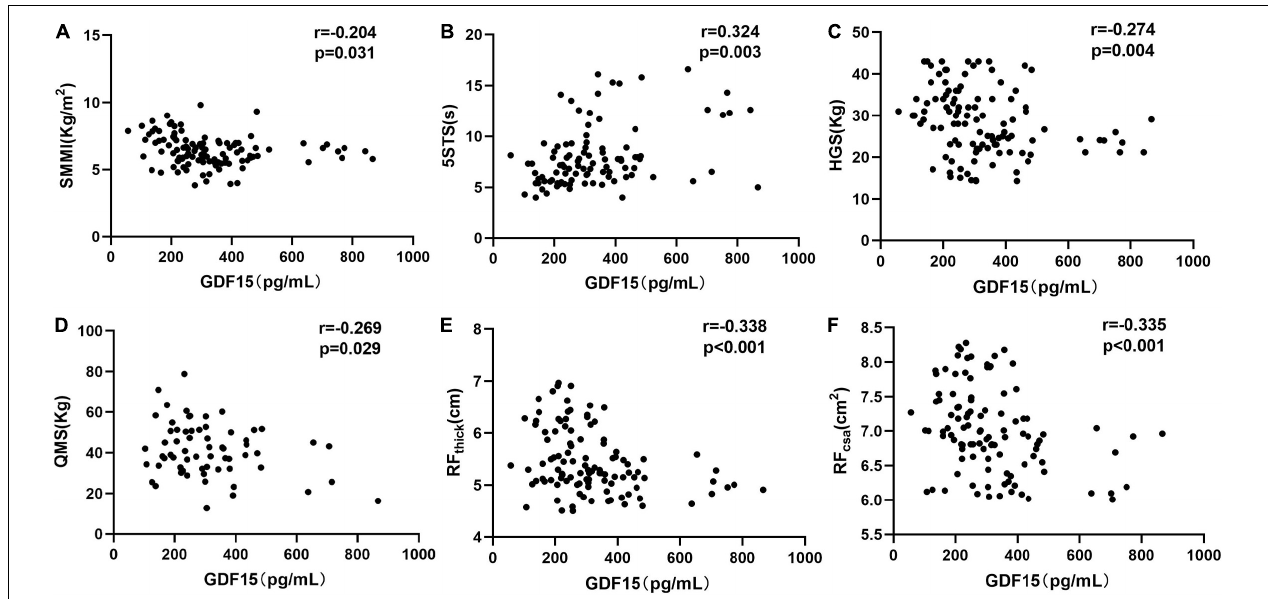
FIGURE 2 | The relationships of serum GDF15 levels with skeletal muscle function in patients with COPD. (A) The relationship between serum GDF15 levels and SMMI ( n = 117; (B) the relationship between serum GDF15 levels and 5STS ( n = 117); (C) the relationship between serum GDF15 levels and HGS ( n = 117); (D) the relationship between serum GDF15 levels and QMS ( n = 111); (E,F) the relationship between serum GDF15 levels and RF thick , RF csa ( n = 114). SMMI, Skeletal muscle mass index; 5STS, Five-time chair stand test; HGS, Handgrip strength; QMS, Quadriceps muscle strength; RF thick , The thickness of the rectus femoris, RF csa , The cross-sectional area of rectus femoris.